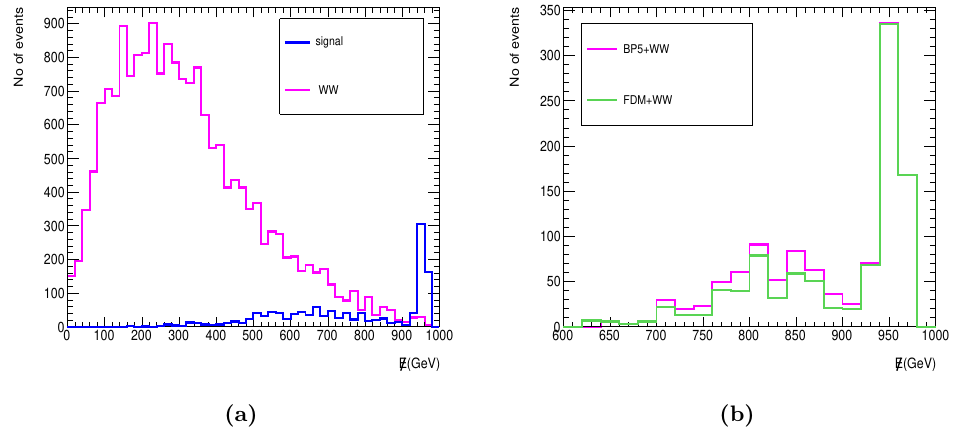
Figure 33. /E distribution for (a) signal (BP5) and WW background, (b) (pink) signal (BP5) + WW background after applying cuts and (green) single component FDM + WW background after applying